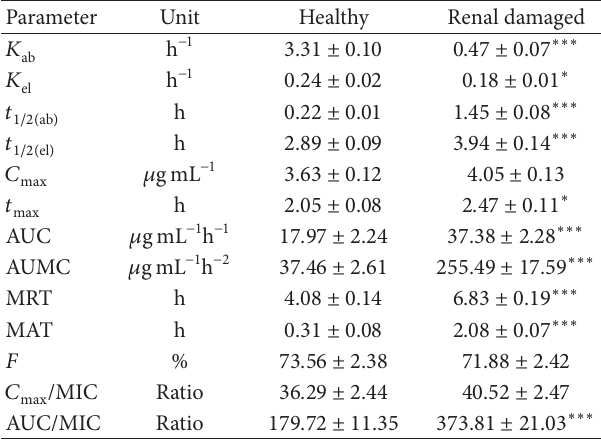
Table 2: Pharmacokinetic parameters of levofloxacin in healthy and renal damaged ducks after a single PO administration of 10 mgkg − 1 bwt ( 𝑛 = 6